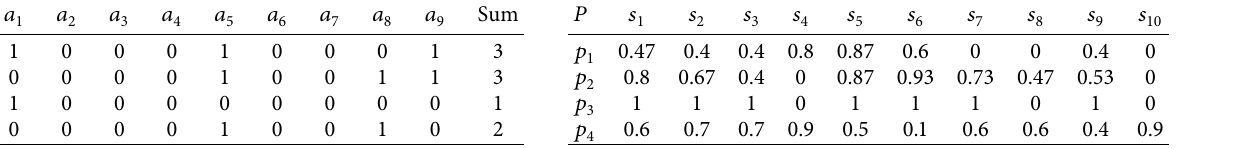
Table 12: Tabular representation of Λ